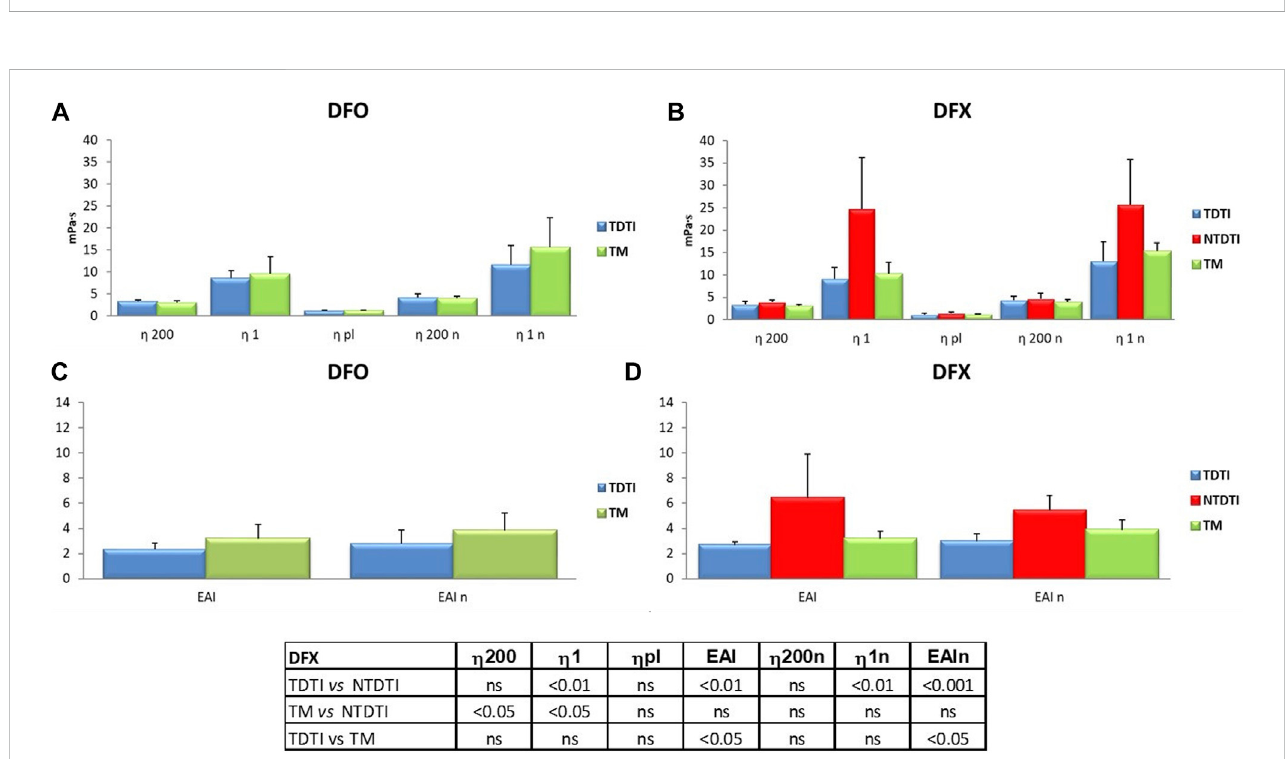
FIGURE 4 The effect of iron chelation therapy on the hemorheological pro fi les of patients with thalassemia intermedia and major. Deferasirox (DFX) and deferoxamine(DFO) wereadministered as mono therapy to 18and 11patients, respectively; η 1 and η 1n: native and normalized hematocritblood viscositiesat low shear rates; η 200 and η 200n: native and normalized hematocrit blood viscosities at high shear rates; EAI and EAIn erythrocyte aggregation index determinaed at native and normalized hematocrit. The comparison between the thalassemia groups showed signi fi cant statistical differences in the patients using DFX; TM: thalassemia major; TDTI: transfusion-dependent thalassemia intermedia; NTDTI: non-transfusion-dependent thalassemia intermedia; ns: not signi fi